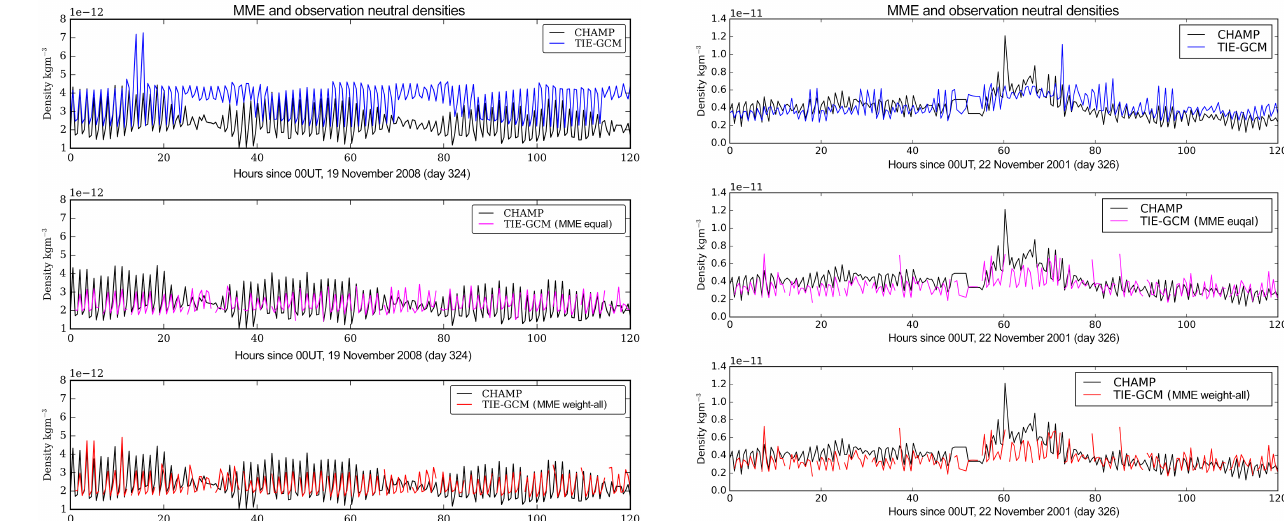
Figure 18. Top panel shows the neutral density from the CHAMP observations and the original TIE-GCM run. The subsequent pan- els then show the CHAMP observations with each of the new TIE- GCM outputs using the MMEs as the initial conditions every 6h.